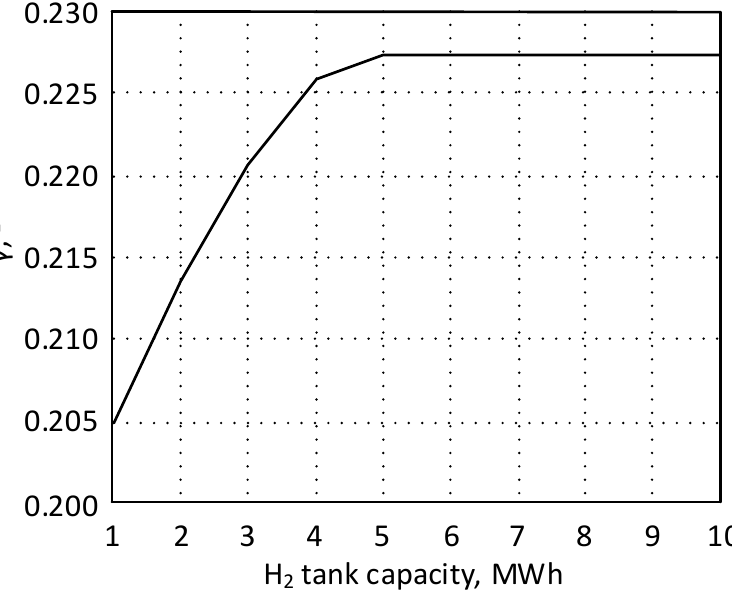
Figure 6. Graph showing the stored energy share factor as a function of hydrogen tank capacity. According to Figure 6, a significant increase in the γ factor is observed from a value of 0.205 (obtained for a 1 MWh H 2 tank) to 0.227, which was found for a 5 MWh buffer tank. When the value of 5 MWh is exceeded, which represents the capacity of the tank, the value of the stored energy share stabilizes at a constant level. The shape of the presented plot is influenced by the operation method of the power to SNG installation used in the computational model. With small reservoir capacities, its filling persisted for a short period of time and the electrolysis installation operates at a constant reduced power, which adapted to the needs of the methanation reactor. In the case of a larger capacity gas buffer, it is possible to operate the hydrogen generator over a longer period of time at its nominal power; when the appropriate power generated by the wind farm is ensured, the simultaneous reduction of the bypass operation time of the electrolysis installation occurs. As can be seen in Figure 6, for a capacity greater than or equal to 5 MWh for the H 2 buffer, the γ coefficient assumes a constant value. When this arises the water electrolysis installation constantly cooperates with the H 2 storage, meaning that the available bypass is not used. Therefore, the hydrogen generator is able to operate constantly at its nominal power, when it is provided by RES. In the analyzed energy storage installation, the direct connection between the H 2 generator and the methanation reactor enables an improved stored energy share factor for hydrogen storage tanks with a small capacity. This